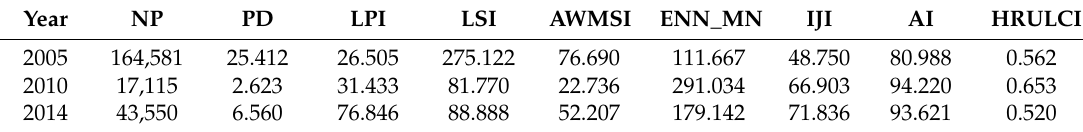
Table 4. Calculation results of landscape pattern index in catchment